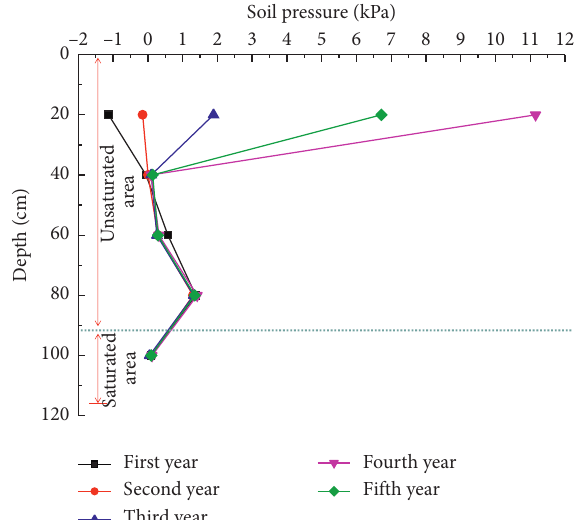
Figure 14: Variations of soil pressure upon the retaining wall back with depth at the end of the five years.